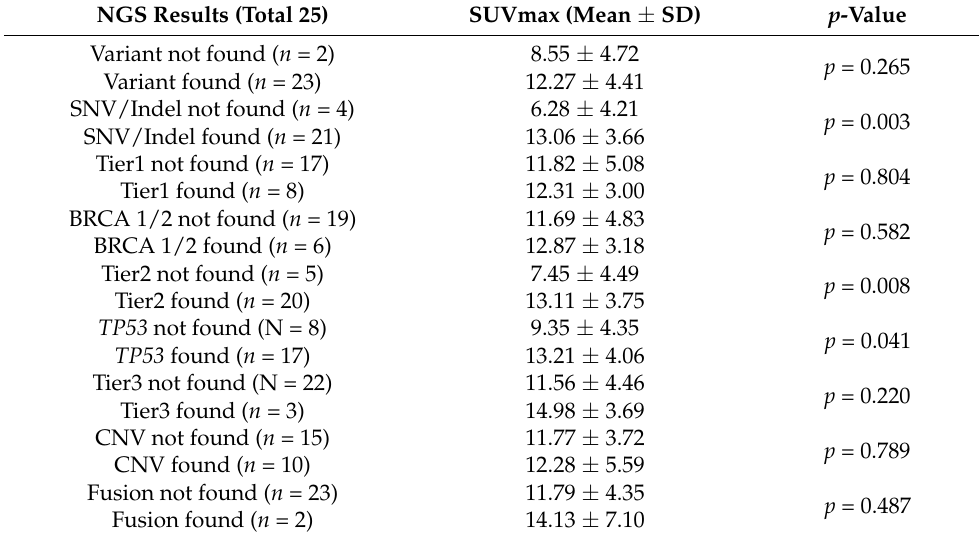
Table 2. Mean and standard deviation of SUVmax according to each variant type found in NGS results. NGS Results (Total